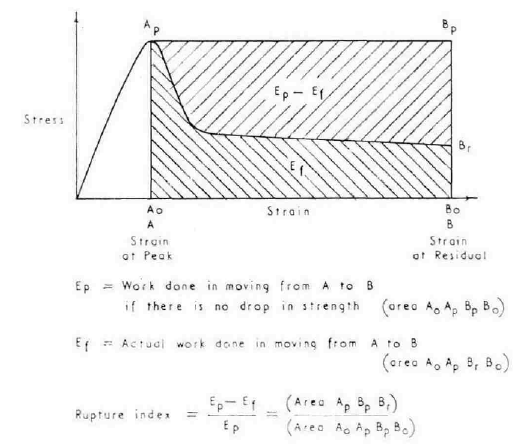
Figure 1. An energy parameters for brittle soils (Bishop,